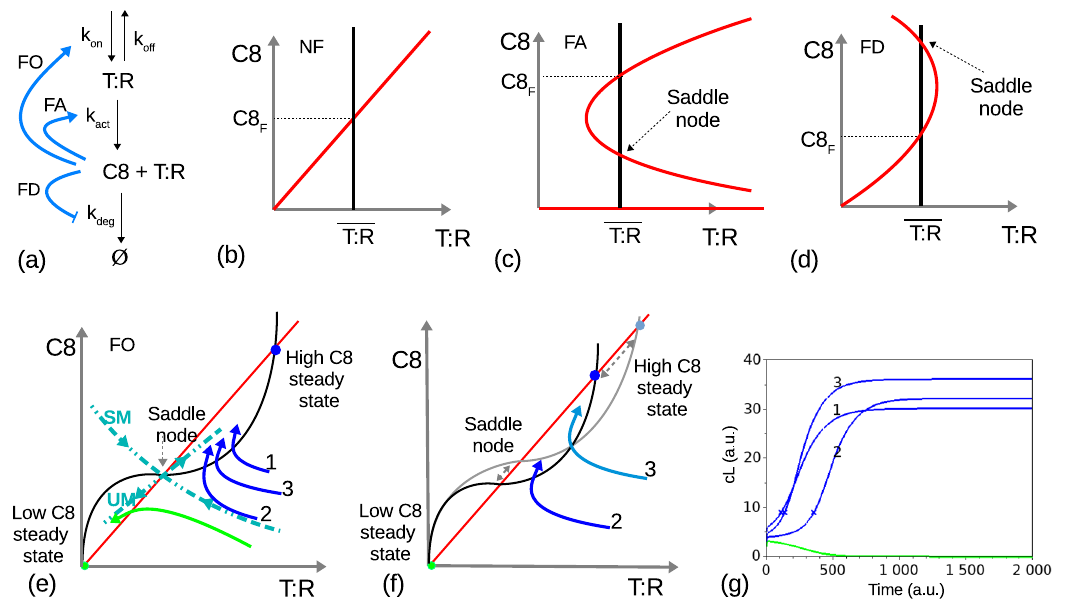
Figure 4. The nullclines and fixed points of the 2D system (2–3), for different network configurations summarized in ( a ): ( b ) in the absence of feedback loops, NF; ( c ) with feedback loop from C 8 to k act , FA; ( d ) with feedback loop from C 8 to k deg , FD; ( e ) with feedback loop from C 8 to k on , FO. The three feedback loops are positive since the final effect of C8 is to increase its own concentration. A schematic view of the 2D system phase plane around the saddle node is shown in case ( e ): trajectories first approach the node along the stable manifold (dashed curve SM) and then are repelled from the node along the unstable manifold (dashed curve UM). Depending on its initial starting point, each trajectory makes a “decision” to converge towards the high or low C8 steady states (respectively, blue and green trajectories); ( f ) Variation in initial conditions also induces changes in the conserved quantities of the system: in this case R 0 changes the total amount of receptors and affects the value of steady states, as represented by the black and grey nullclines; ( g ) A large variability is obtained from a small neighborhood of initial conditions, both in terms of maximal slope and activation